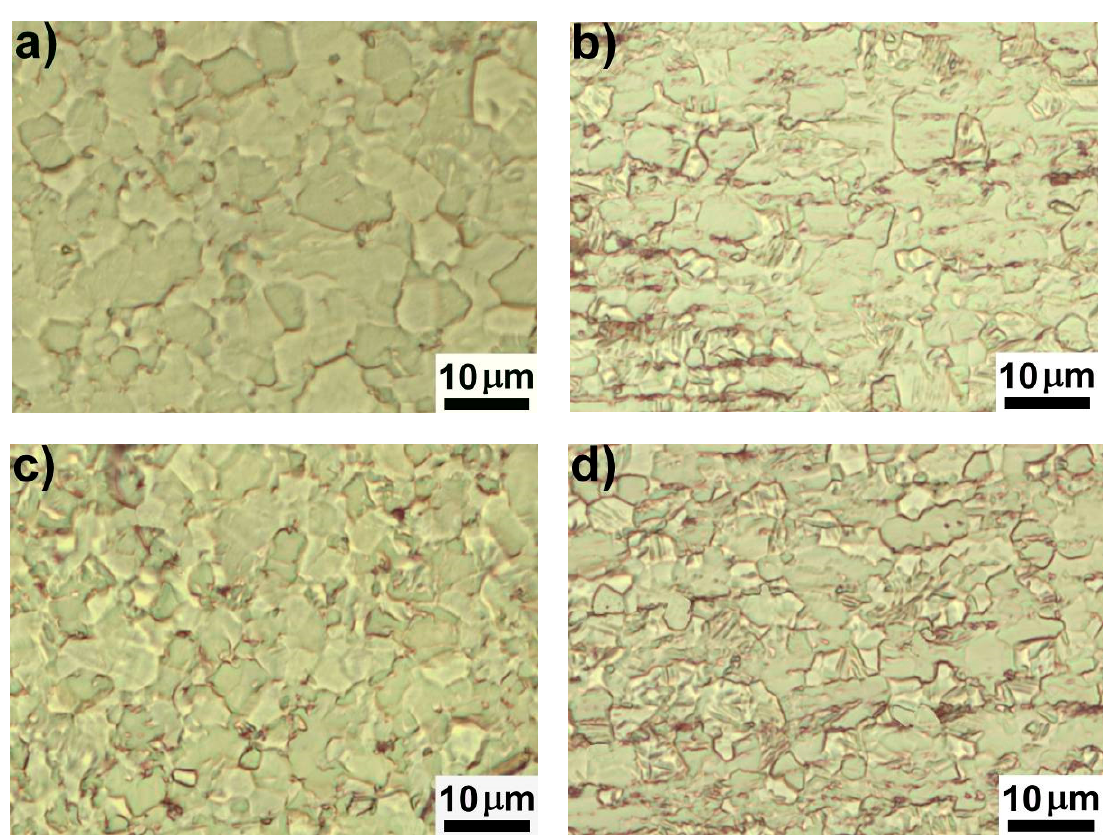
Figure 9. Microstructures of manufactured Ti Gr4 rods revealed by etching, visible under higher magnification: ( a ) variant V2, transverse section, ( b ) variant V2, longitudinal section, ( c ) variant V4, transverse section, ( d ) variant V4, longitudinal section.